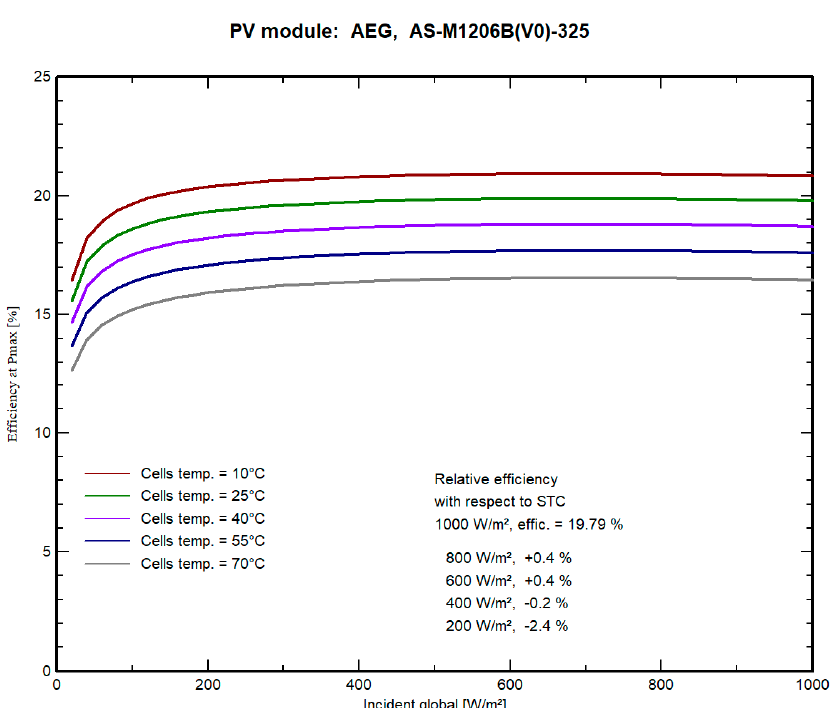
Figure 5. Efficiency curve for the selected monocrystalline module .